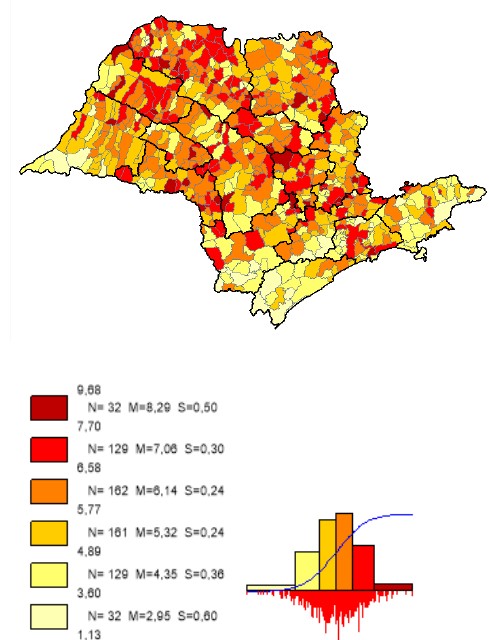
Figure 3. Distribution map of potential years of life gained in municipalities in the state of SP, fixed effects. Note: Choropleth maps, consisting of six divisions, using the following limits—minimum value; 5th percentile; 25th, 50th and 75th percentiles; 95th percentile and maximum value. For each interval, the number (N) of municipalities, their mean (M) and standard deviation (S) are described. The histograms contain bars proportional to the number of localities in each division ( Philcarto images).